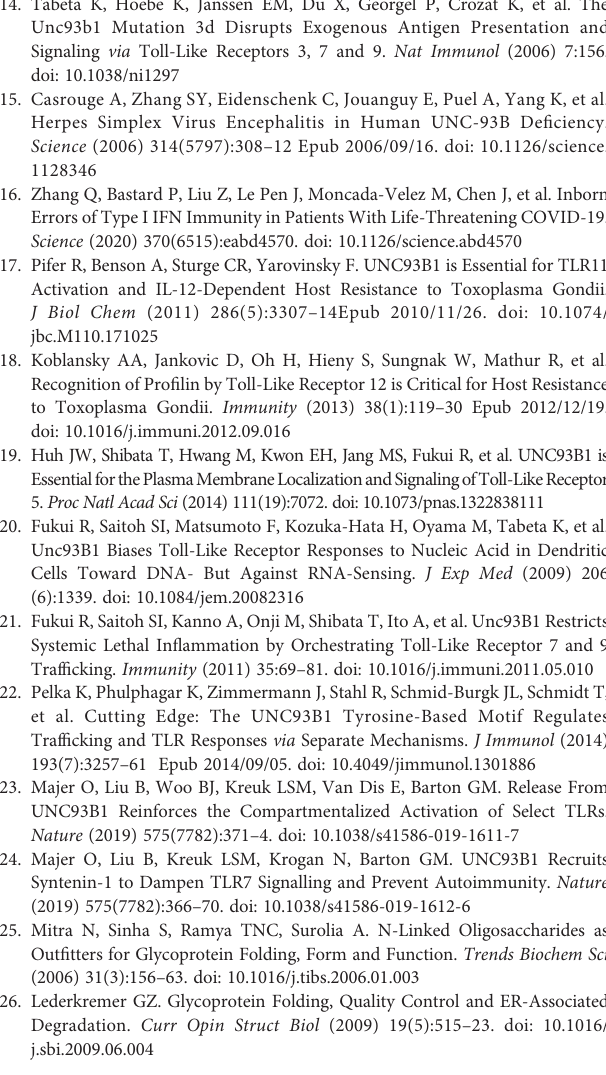
shown (B) . (C) UNC93B1 KO iBMDMs expressing wild type or mutant UNC93B1-GFP were stimulated with indicated TLR agonists for 4 h and TNF- a production was analyzed by intracellular cytokine staining followed by fl ow cytometry. The proportion of TNF- a + cells are shown. Data represent means ± SD (n = 3). *p < 0.05, **p < 0.01 (Student ’ s t -test) Supplementary Figure 2 | Structure comparison of TLRs in complex with UNC93B1. (A) Superposition of the TLR3-UNC93B1 complex (PBB 7C76, green for TLR3 and pink for UNC93B1) and the monomeric TLR7-UNC93B1 complex (PDB 7CYN, blue for TLR7) using UNC93B1 as reference. Due to the absence of availablestructureforTLR9-UNC93B1complex,theLRRCTdomain(C765-Q805) of TLR9 ectodomain (PDB 3WPF, yellow for TLR9) is aligned to TLR7 LRRCT domain (C787-L828), and TLR9 transmembrane region is modeled using TLR3 transmembraneregionasatemplate.GlycansonUNC93B1(N251andN272)and TLRs are indicated as spheres and colored with light brown, red, and orange, respectively.GlycansonTLR7areadoptedfromhigh-resolutionstructureofTLR7 ectodomain (PDB 6LVZ). (B) The TLR3-UNC93B1 complex. (C) The monomeric TLR7-UNC93B1 complex. (D) The modeled TLR9-UNC93B1 complex. The solid lines and dotted lines represent the ring plane of each TLR ectodomain and the planeperpendiculartothemembrane,respectively.Thedegreesbywhichthetwo planes are separated are